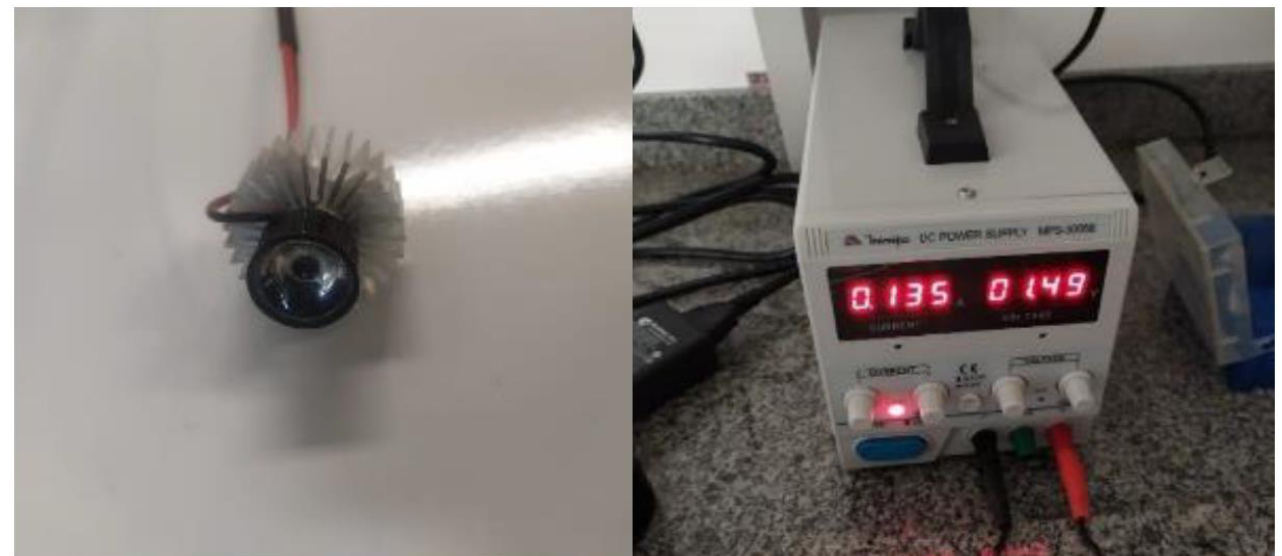
Figure 2. LED device . Author’s personal collection .